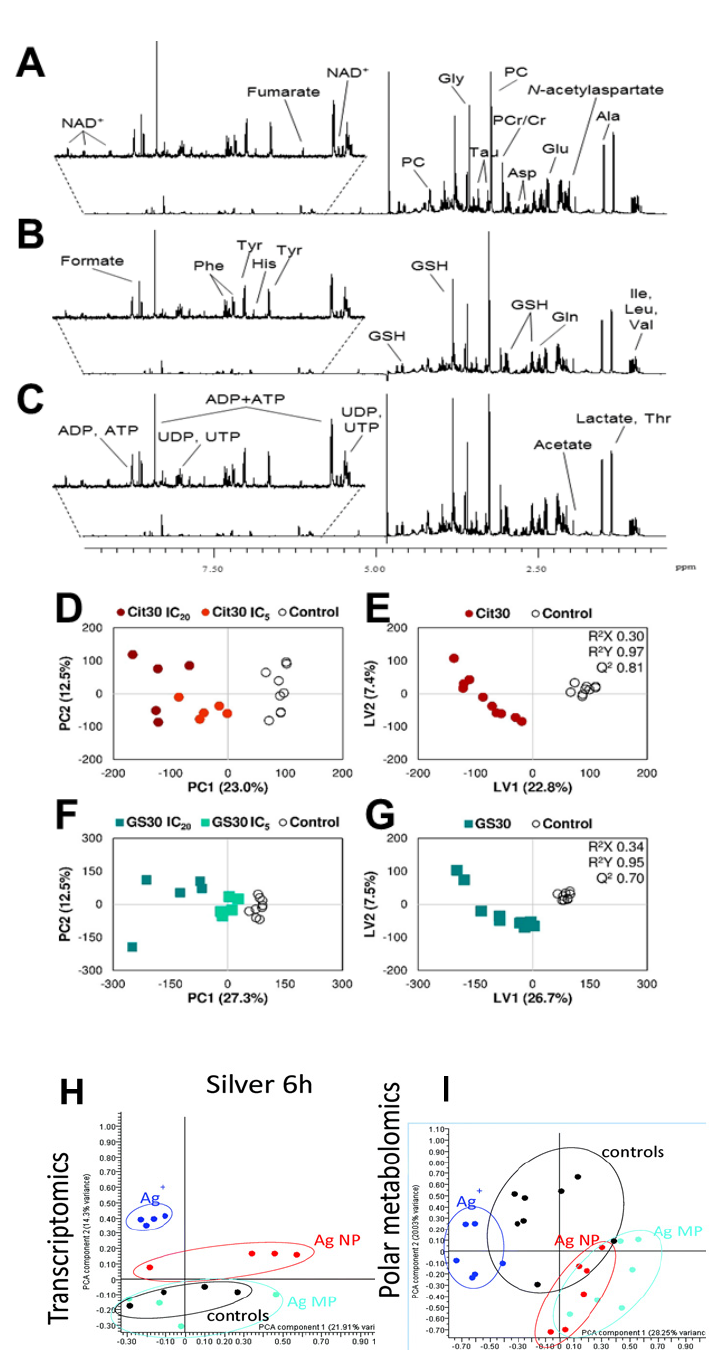
Figure 7. Solution-state NMR experiments: 1 H variable spectral data of metabolites from AgNPs exposure in HepG2 cells, using a 5 mm probe: ( A ) controls, ( B ) Cit30 AgNPs, and ( C ) GS30 AgNPs. Multivariate statistical analysis of 1 H-NMR spectral data from HepG2 control cells and cells exposed to ( D , E ) Cit30 and ( F , G ) GS30 AgNPs. ( D , F ) The PCA score plot. ( E , G ) The PLS-DA score plots produced by pairwise comparisons (control and AgNPs). Data revealed that cancer cells have high quality (i.e., Q 2 = 0.8 and 0.7 for Cit30 and GS30 models, respectively). Abbreviations: Cit30, citrate-coated 30 nm AgNPs; GS30, green synthesis 30 nm AgNPs. Reprinted with permission from Reference